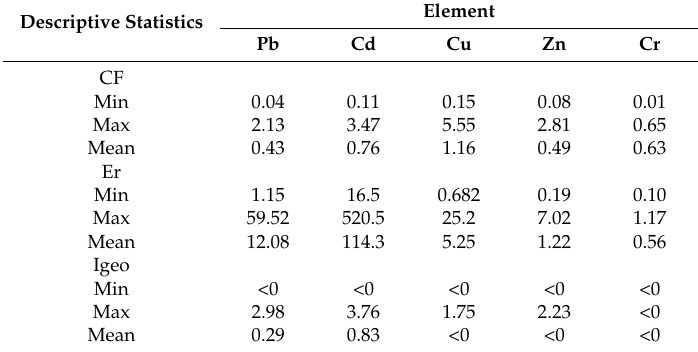
Table 10. Contamination factor (CF), ecological risk factor (Er), geo-accumulation index (Igeo) and ecological risk index (RI) values of heavy metals in